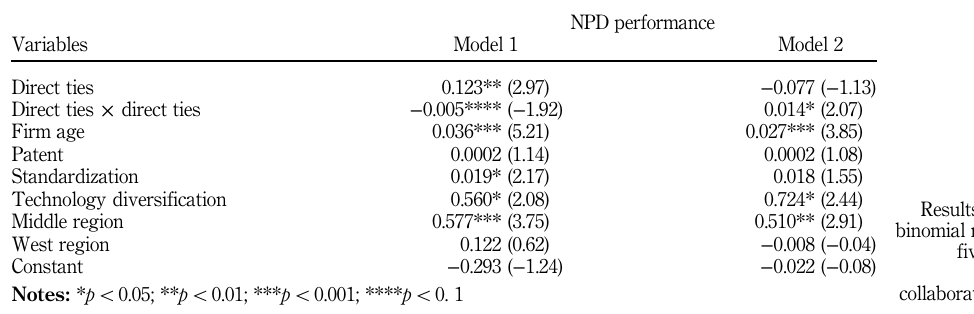
Table IV. Results of negative binomial regression of five-year ’ s and three-year ’ s collaboration